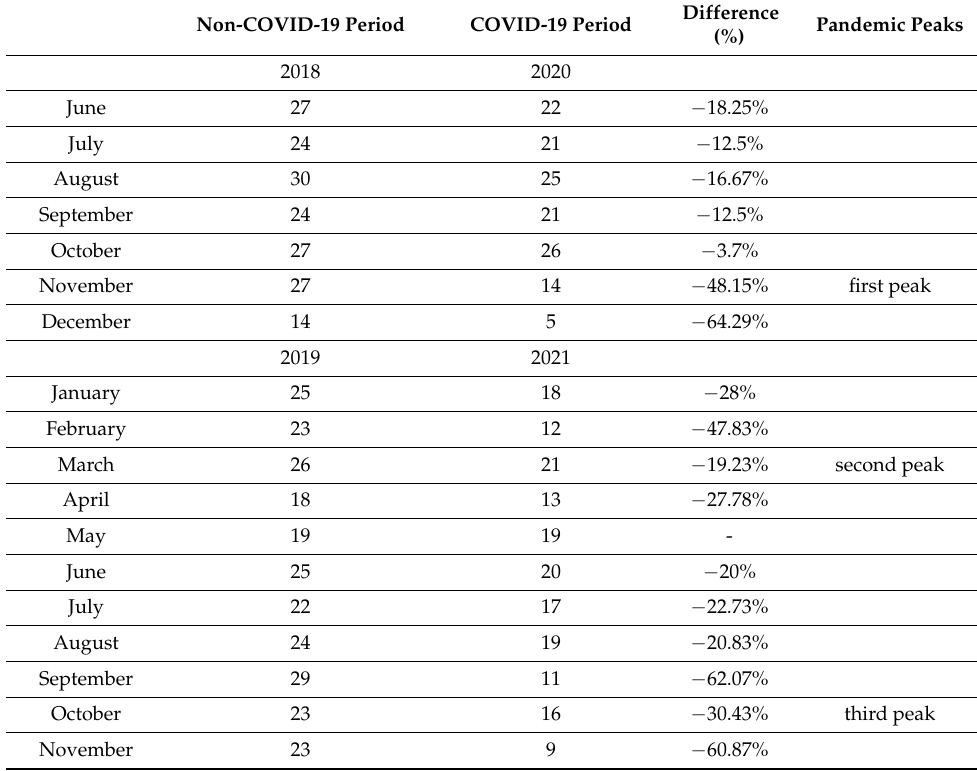
Table 3. Numbers of in-patients admitted each month for both